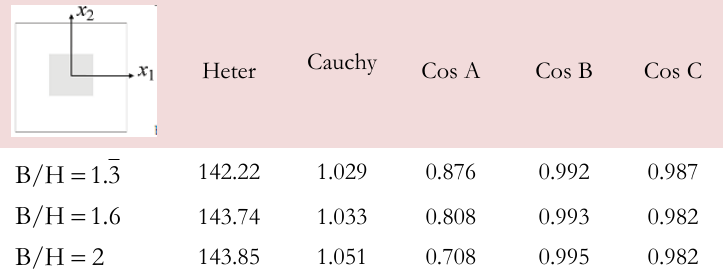
Table 4 Structural stiffness for different ratios of B/H in the case of UC2: Heter = micromechanical model; Cauchy= homogenized first order model; Cos A = homogenized Cosserat with Procedure A ; Cos B = homogenized Cosserat with Procedure B ; Cos C = homogenized Cosserat with Procedure C